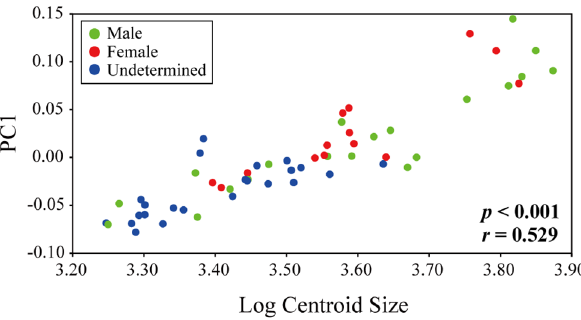
Fig 5. Regression analysis of PC1 on log centroid